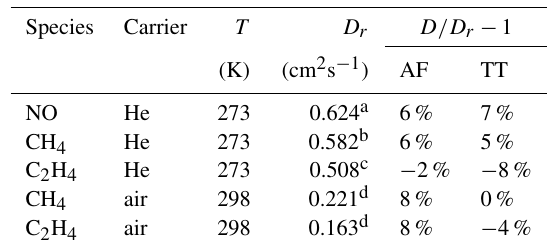
Table 2. Measured diffusion coefficients D at the reference temper- ature T and standard pressure (101325Pa); reference data of dif- fusion coefficients D r . With 298K as a reference temperature, the measured diffusion coefficients were extrapolated to this tempera- ture using Eq. (5).